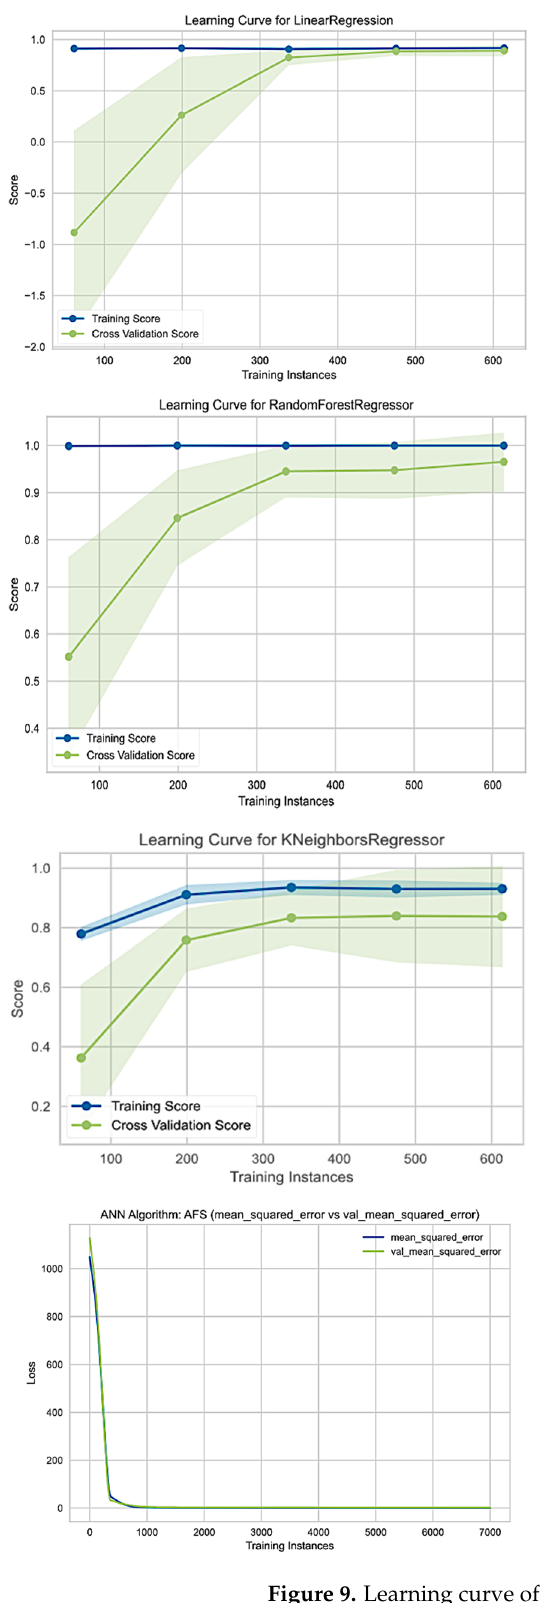
15 of 22 Figure 8. Best fit line of different ML models for left column BFS and right column AFS methods.